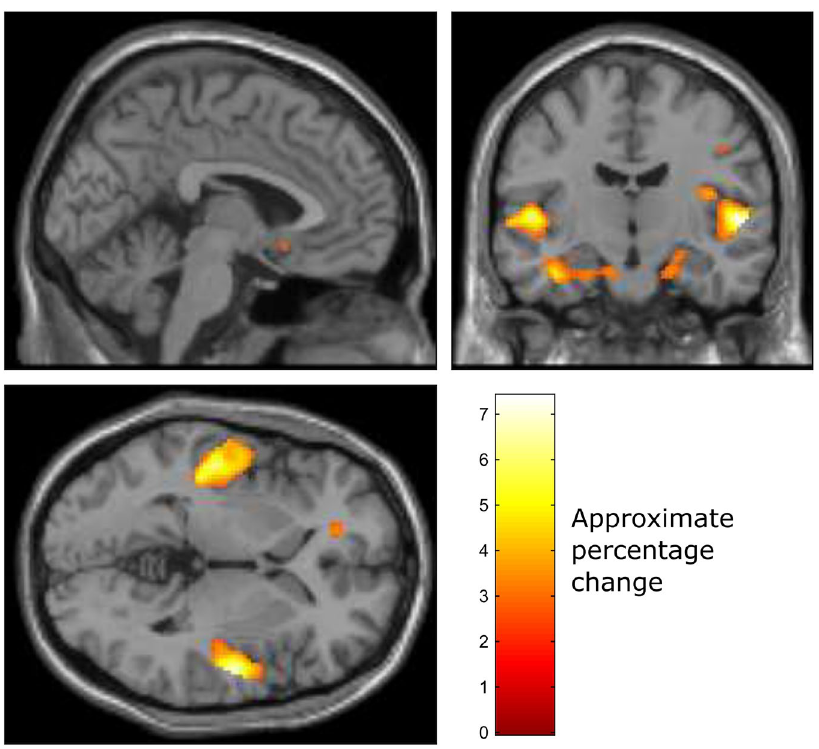
Figure 1. Voxels that significantly differ in activity between music listening and no music trials over all participants ( p < 0.001 , not corrected for multiple comparisons). The colour scale indicates approximate percentage change in BOLD activity. The voxel activities are averaged over all participants (2nd level analysis) and fitted to a standard T1-weighted image.